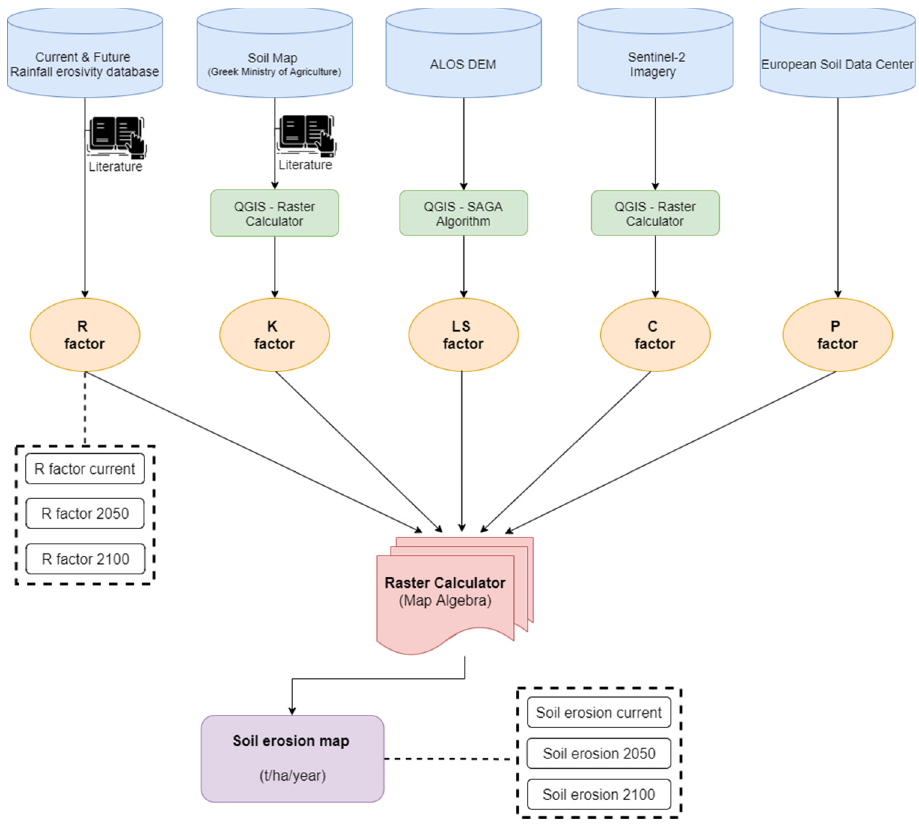
Figure 2. Methodological flowchart for modeling soil loss using RUSLE model.